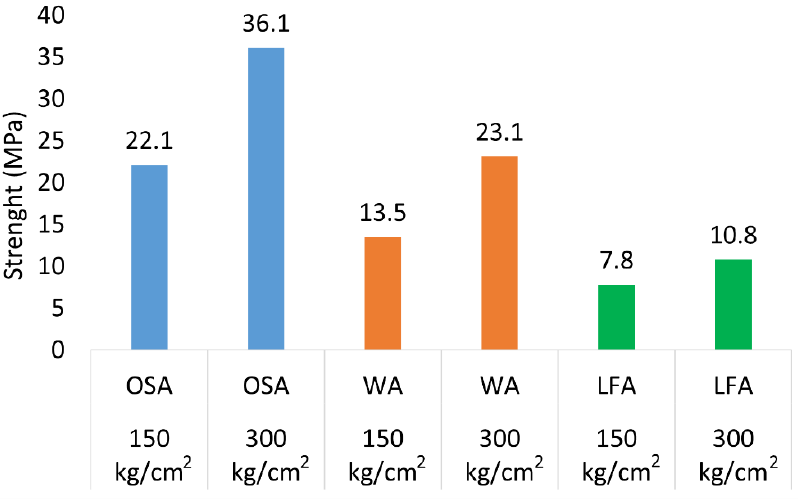
Figure 6. Compressive strength values at different compaction pressures for OSA, WA and LFA (10 bar, 100% CO 2 , 25 ◦ C) (Average values obtained from min. 4 samples (std. deviation <